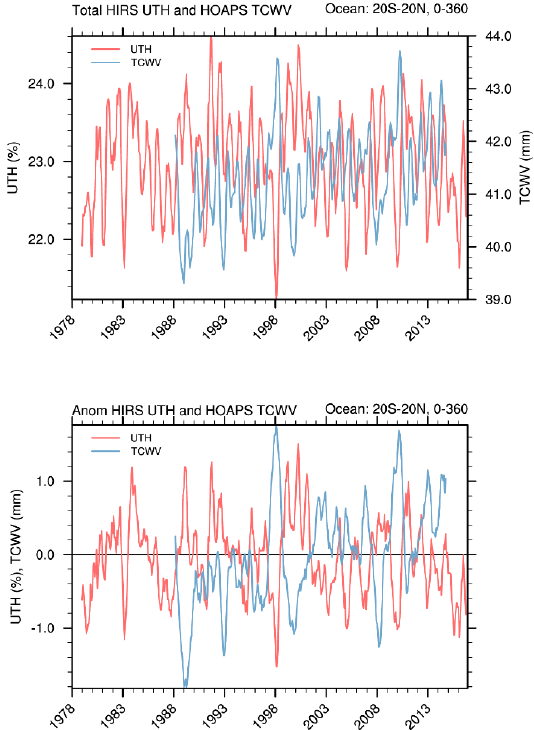
Figure 1. Time series of High-Resolution Infrared Radiation Sounder (HIRS) upper tropospheric humidity (UTH) and Hamburg Ocean Atmosphere Parameters and Fluxes from Satellite Data (HOAPS) total column water vapor (TCWV) for 20°S–20°N over ocean surfaces. The upper panel shows monthly mean values of UTH and TCWV over ocean surfaces, and the lower panel shows the corresponding anomalies. A five-month moving average is